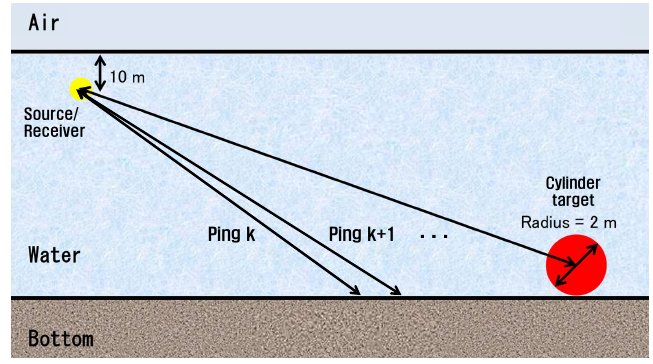
Figure 1. Schematic for the underwater situation considered in the